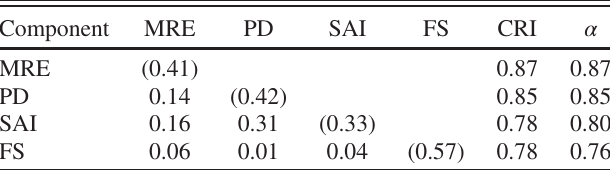
TABLE VII. AVE, squared intercomponent correlation, CRI, and Cronbach ’ s α .